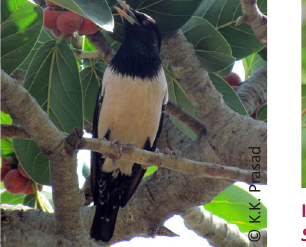
Image 81. Eurasian Golden Oriole Oriolus